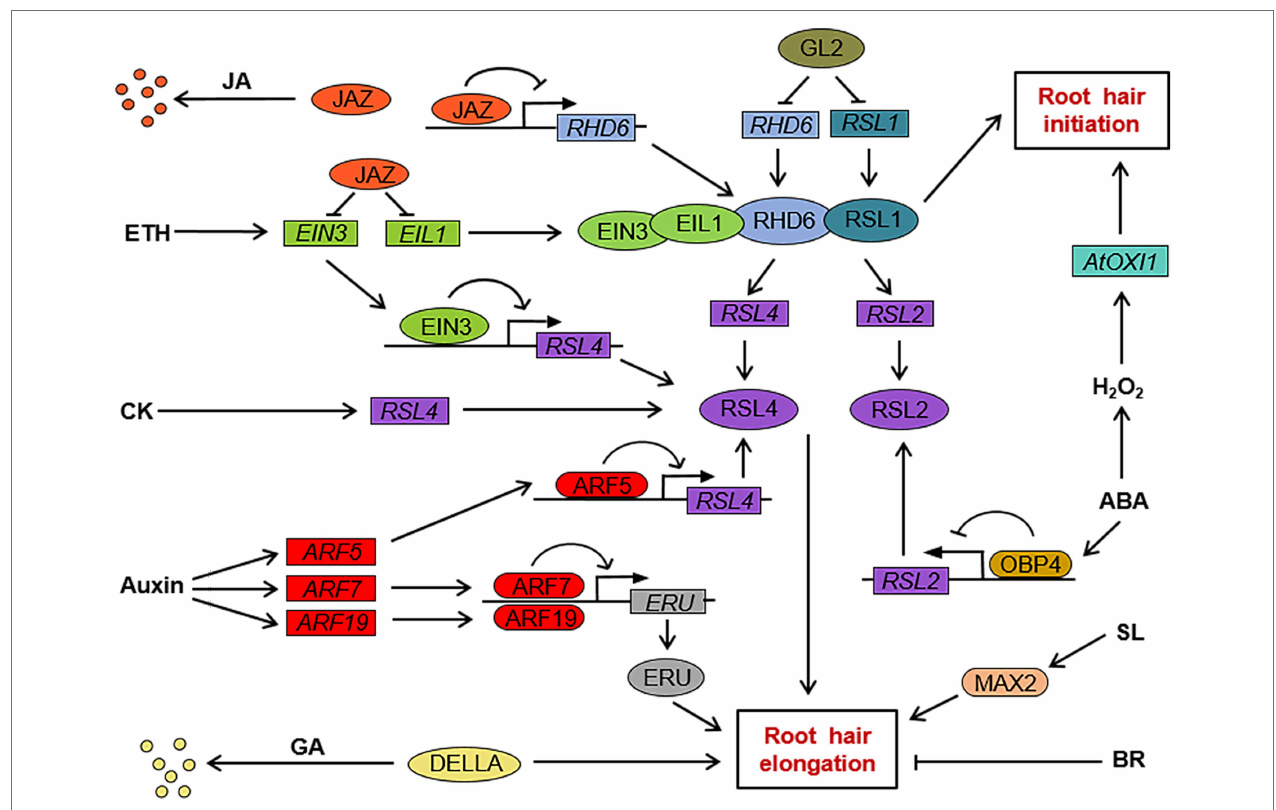
FIGURE 2 | The regulation network of phytohormones on root hair initiation and elongation in Arabidopsis . GL2 inhibits the expression of ROOT HAIR DEFECTIVE 6 ( RHD6 ) and RHD6 LIKE1 ( RSL1 ), which are positive regulators of root hair initiation and elongation. RHD6 and RSL1 promote the expression of RSL2 and RSL4 , which in turn promote root hair elongation by upregulating the expression of elongation genes. JAZ protein, a repressor of JA signal transduction, inhibits RHD6 transcription and interferes with the interaction between RHD6 and RSL1. JAZ protein also inhibits the transcription of EIN3 and EIL1 in the ethylene signaling pathway. EIN3/EIL1 can form a complex with RHD6/RSL1 to promote root hair initiation, and EIN3 binds to the promoter region of RSL4 to promote its transcription. The auxin response factor ARF5 also binds to the RSL4 promoter region to induce RSL4 expression, and the auxin response factor ARF7 and ARF19 bind to the promoter region of ERU to induce ERU expression. GA negatively regulates the expression of root hair elongation genes through DELLA-mediated signal transduction. ABA induces the accumulation of OBP4 protein, and OBP4 binds to the RSL2 promoter region to inhibit RSL2 expression. ABA also induces the expression of AtOXI1 and other root hair initiation-related genes by H 2 O 2 production. CK can promote root hair elongation by promoting RSL4 expression. SL induces root hair elongation-related gene expression through the MAX2-mediated signal transduction pathway. BR negatively regulates the expression of root hair elongation-related genes. → , positive regulation; ┤ , negative regulation. JA, jasmonate; ETH, ethylene; CK, cytokinin; GA, gibberellin; BR, brassinosteroid; SL, strigolactone; and ABA, abscisic